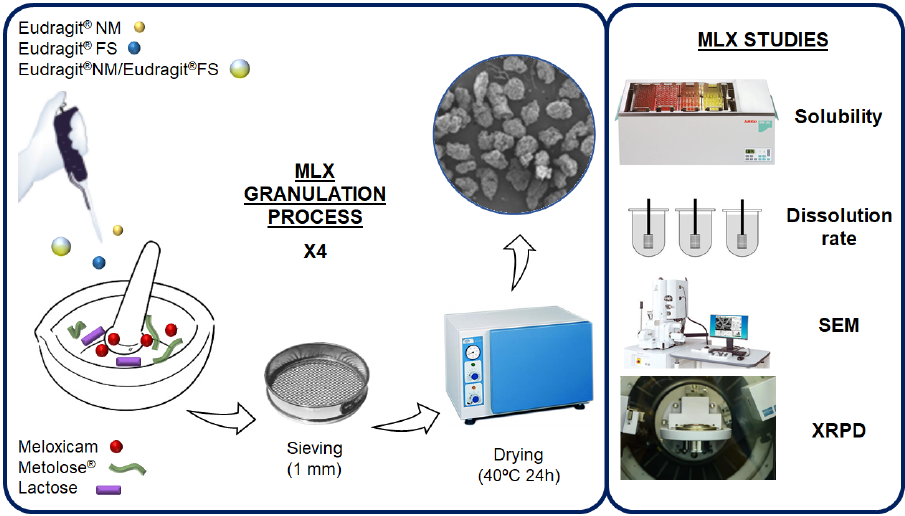
Figure 2. Preparation procedure for MLX multiparticulate colonic systems and their characterization.